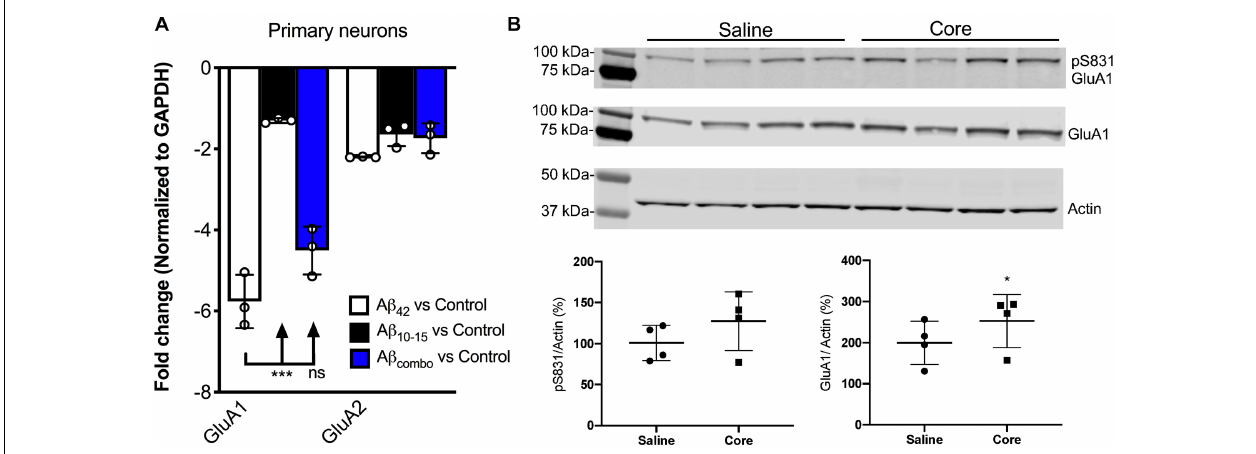
FIGURE 2 | N-A β Core normalizes AMPAR1 expression in an in vitro A β neurotoxicity model of primary hippocampal neurons and in vivo in hippocampi of 5xFAD APP/PS1 mice. (A) Normalized average expression of AMPA receptor GluA1 and GluA2 transcripts in B6.SJL mouse hippocampal neuron cultures exposed to full-length A β 1 − 42 (A β 42 ), the N-A β core (A β 10 − 15 ) or the combination (combo), as measured via qPCR. Data are means ± SD. N = 3 cultures for each condition. *** p = 0.000001 (Bonferroni post hoc tests for one-way ANOVA comparison between A β 42 and A β 10 − 15 ). There was no statistical difference between expression for any condition for GluA2. (B) Expression of pAMPAR1 (pGluA1) or total AMPAR1 (GluA1) in the hippocampi of 5xFAD mice injected with sterile saline or N-A β core (Core), as measured using western immunoblot. N = 4 mice for each condition. Total GluA1: * p < 0.0001